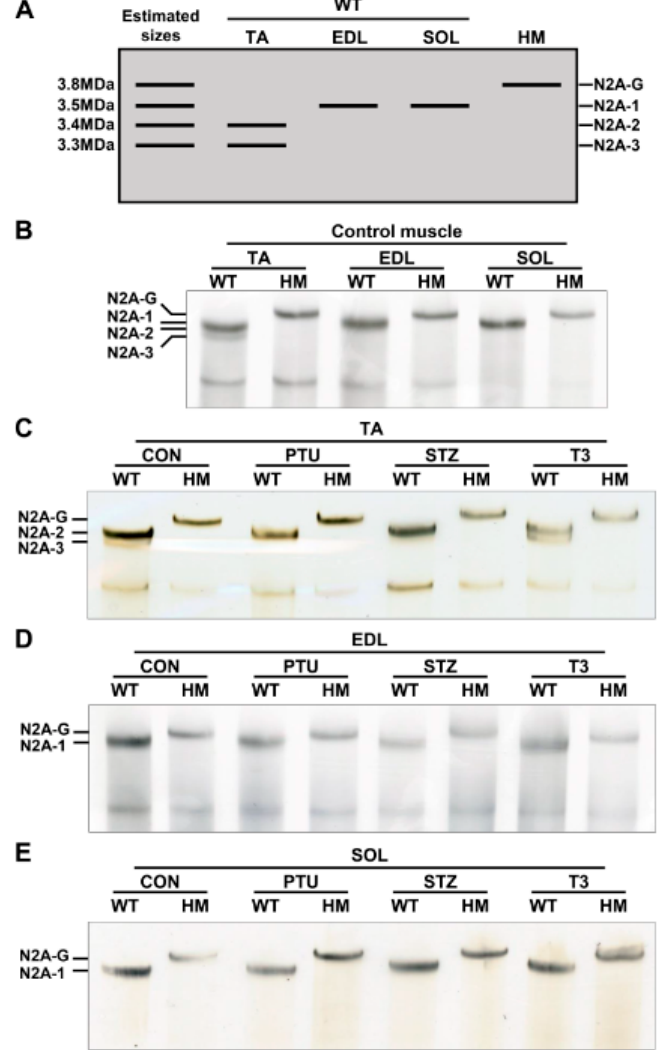
Figure 2. Hormonal effects on titin isoform switching in different muscle types. ( A ) Schematic diagram of titin isoforms and estimated sizes in skeletal muscle; ( B ) Titin isoform switching in different muscle types between WT and HM without treatment; ( C – E ) Titin isoform switching in different muscle types between WT and HM with PTU, STZ and T3 treatment respectively. WT, wildtype; HM, RBM20 homozygous knockout; CON, control; PTU, propylthiouracil; STZ, streptozocin; T3, triiodothyronine; TA, tibialis anterior; EDL, extensor digitorum longus; SOL, soleus; N2A-G, giant isoform; N2A 1-3, titin isoforms; n = 3 for all treated and untreated muscles.